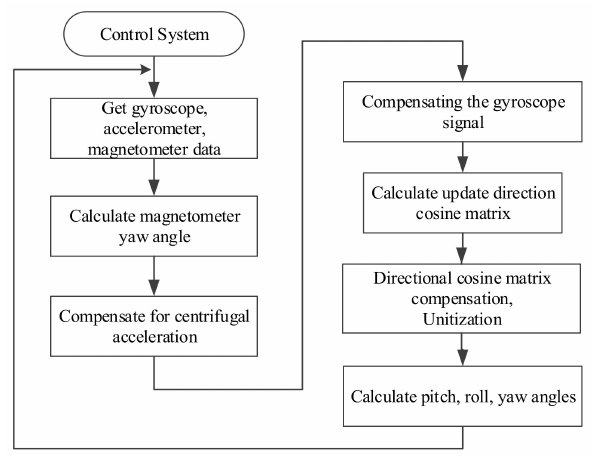
Figure 9. DCM attitude solution program flowchart.